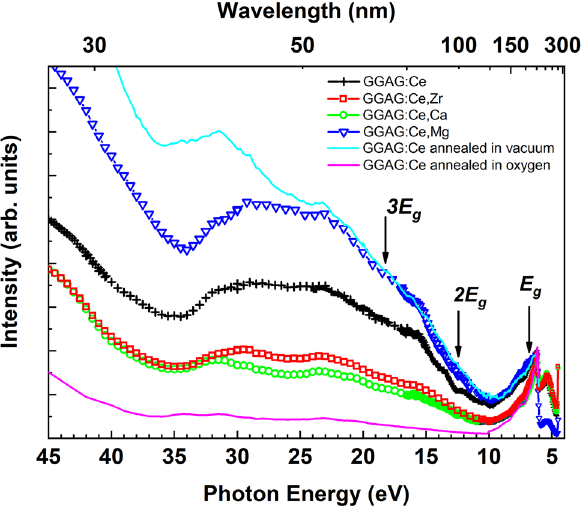
Figure 4. The excitation spectra of Ce 3+ emission (530 nm) in VUV spectral range measured at 10 K for the co-doped GGAG:Ce single crystals as well as for the annealed crystals. All spectra are normalized to the excitonic